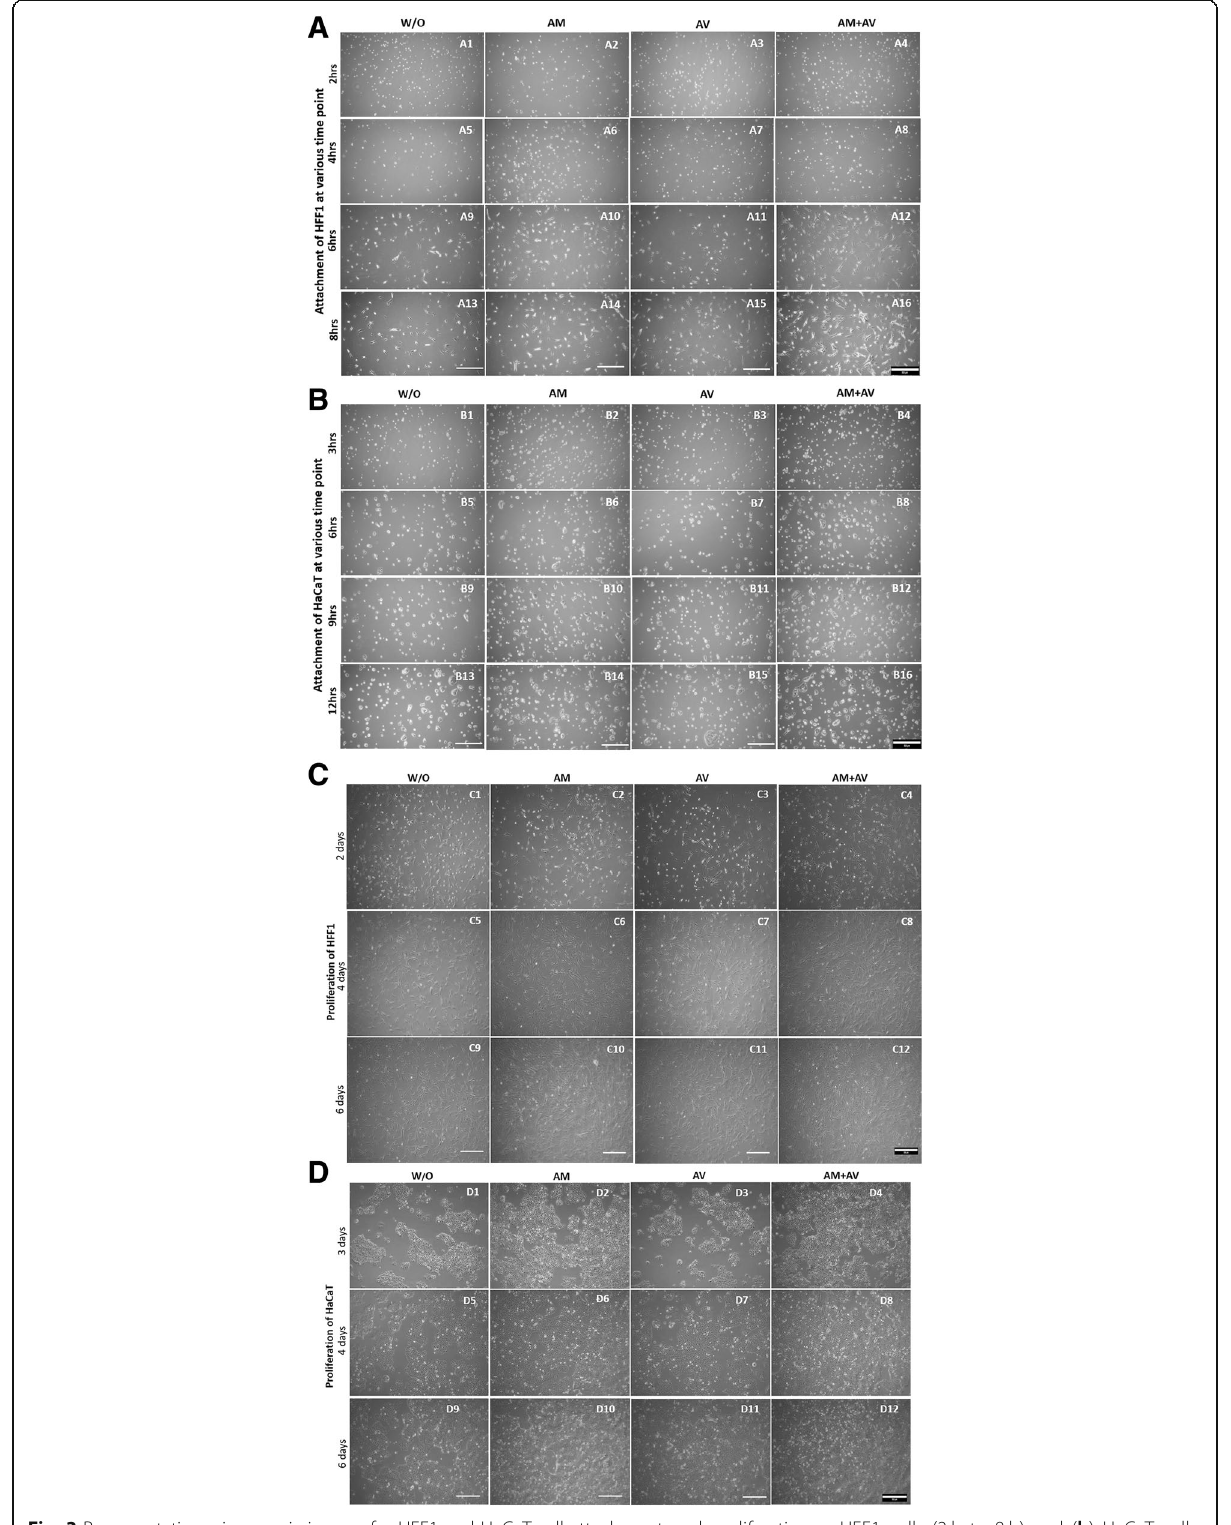
Fig. 3 Representative microscopic images for HFF1 and HaCaT cell attachment and proliferation. a HFF1 cells (2 h to 8 h) and ( b ) HaCaT cells (3 h to 12 h) attachment test. c Proliferation tests of HFF1 for 2, 4, and 6 days. d The proliferation of HaCaT from day 3 to day 6 in media with and without